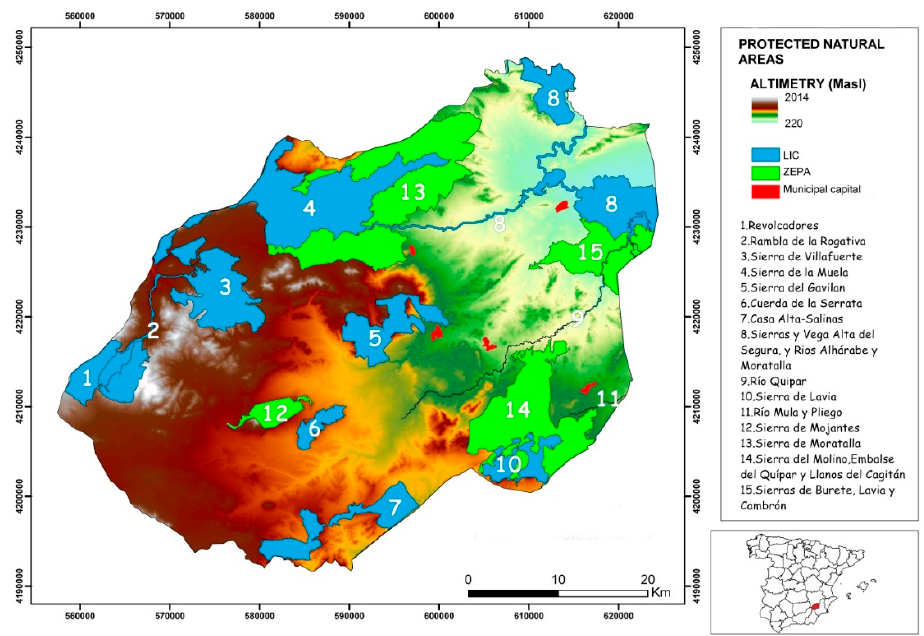
Figure 6. Spatial distribution of protected natural lands. (LIC: Sites of Community Interest, and ZEPA: Area of Special Protection for Birds). Source: Authors.